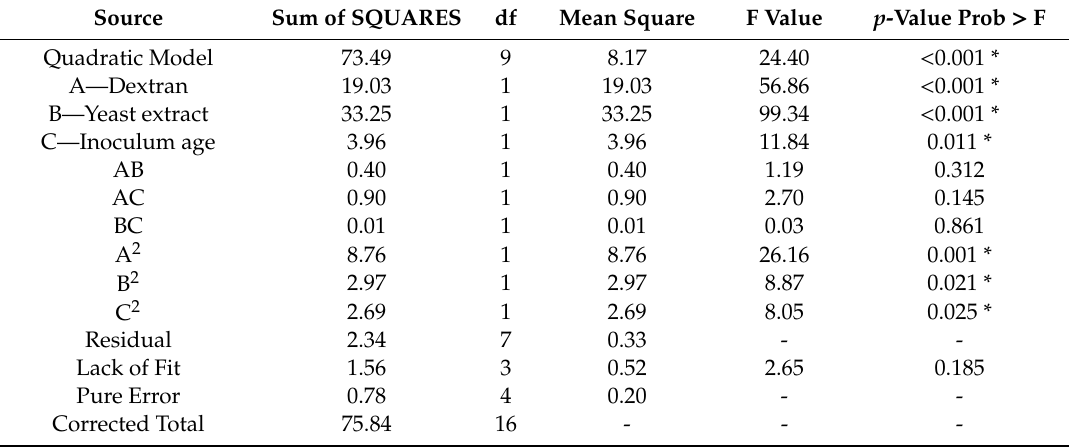
Table 4. Statistical analysis of factors a ff ecting the dextranase production with the Box–Behnken design experiment.